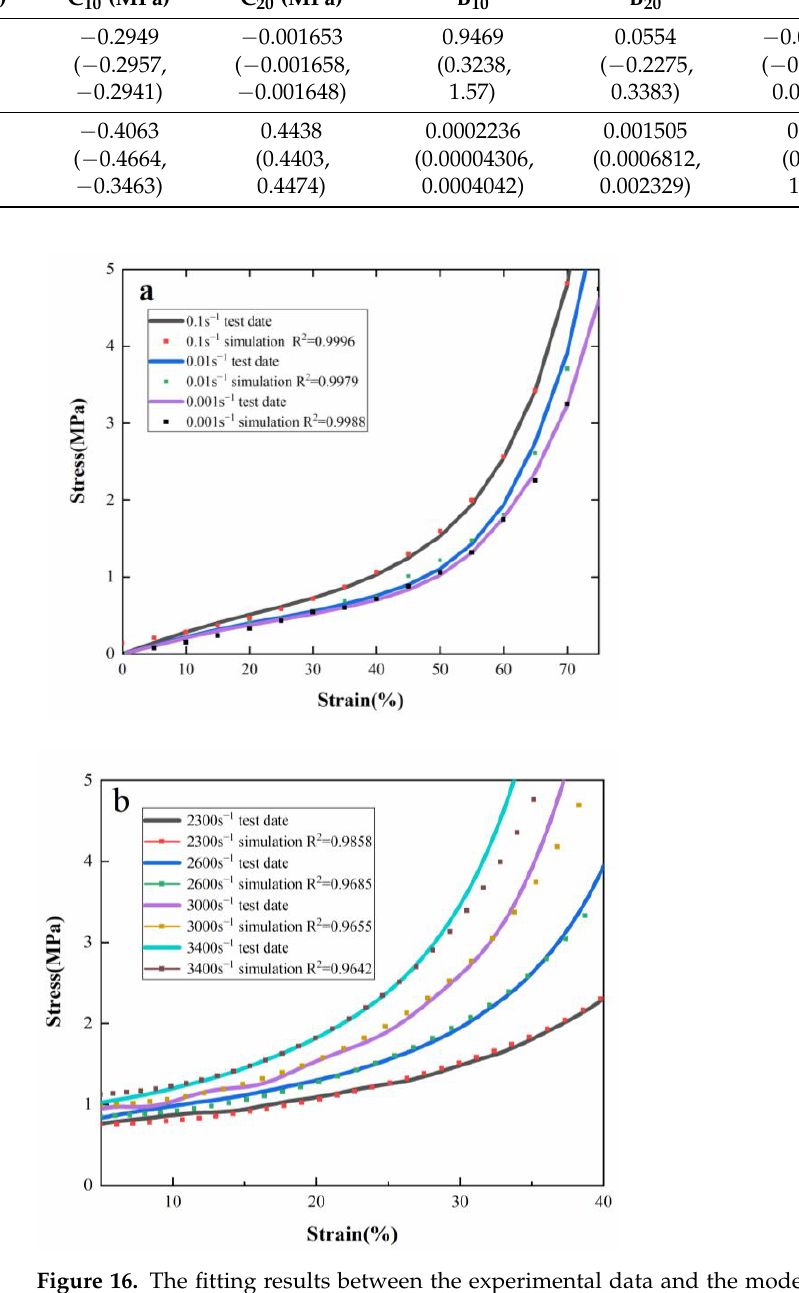
Figure 16. The fitting results between the experimental data and the model: ( a ) quasi-static test, ( b ) dynamic test.